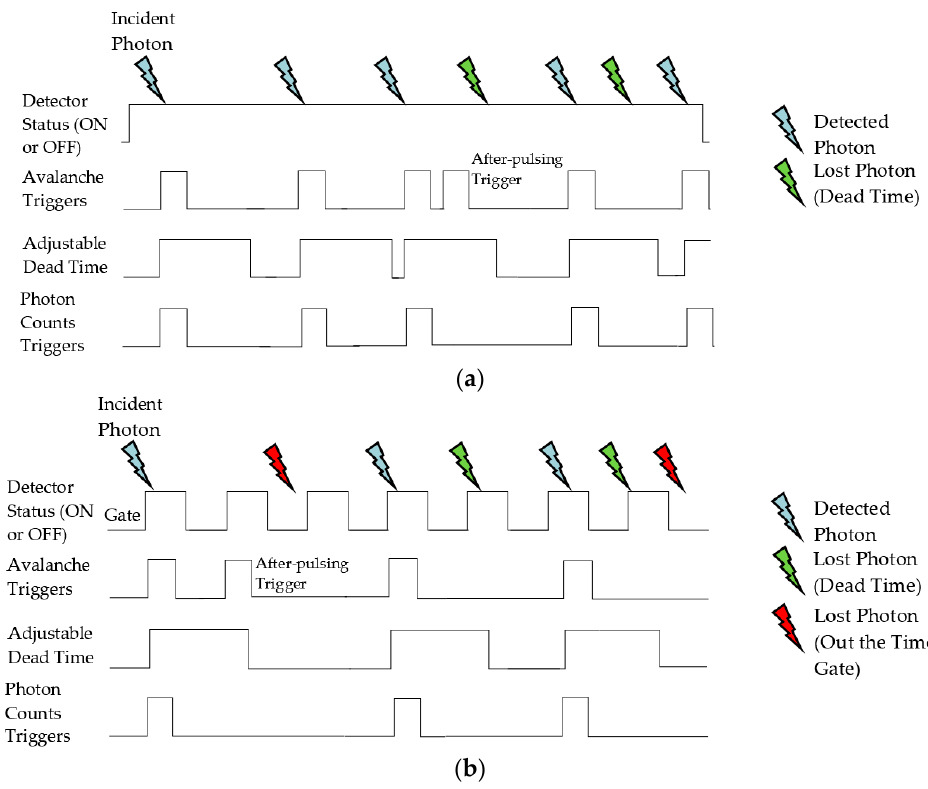
Figure 8. Photon counting process for identical incident photons using ( a ) FR detector, ( b ) TG detector. Reasons of missing photons are indicated on the right for each one.